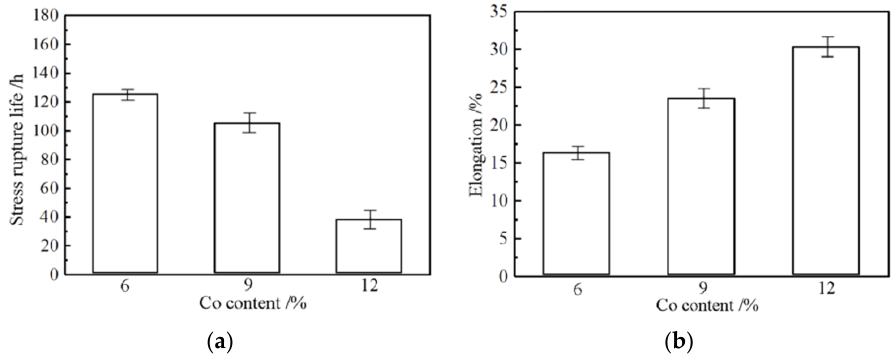
Figure 6. Influence of Co content on the stress rupture properties of the alloy at 1100 °C/137 MPa: ( a ) stress rupture life and ( b ) elongation.